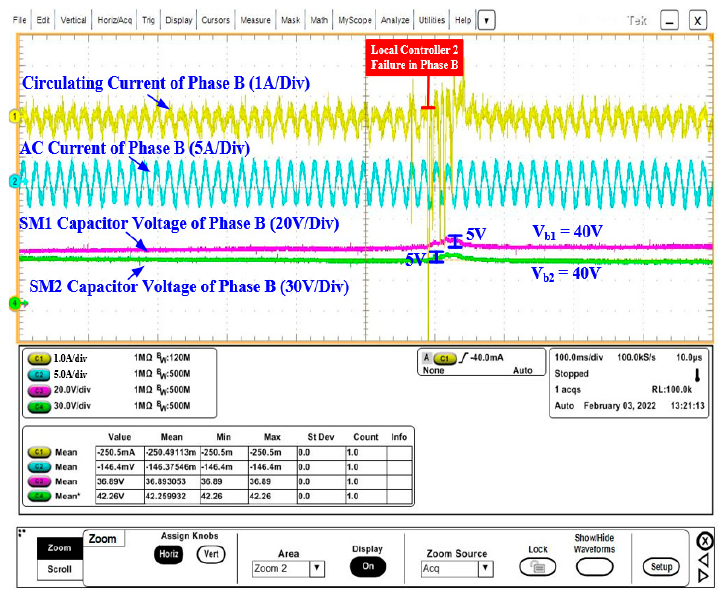
Figure 18. System parameters under failure of one local controller.